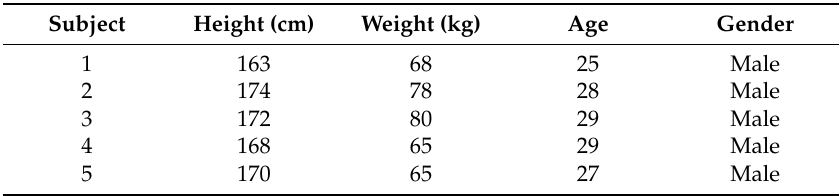
Table 1. Information of subjects participated in the study.